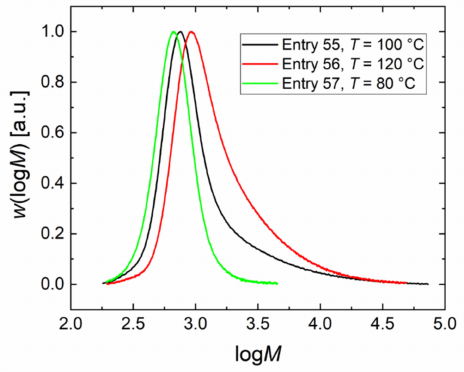
Figure 9. SEC traces of DMC-NO 3 catalyzed PO CO 2 copolymerization at N =